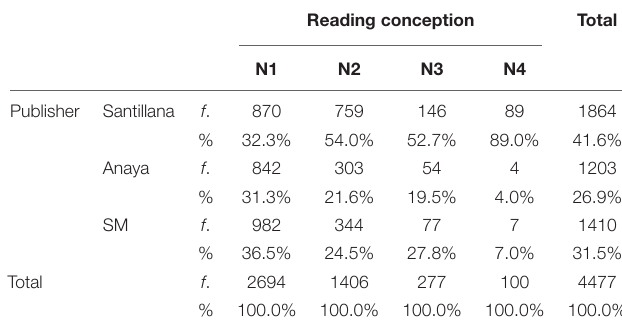
TABLE 6 | Levels of cognitive-reading progress (N4 – literacy criticism).